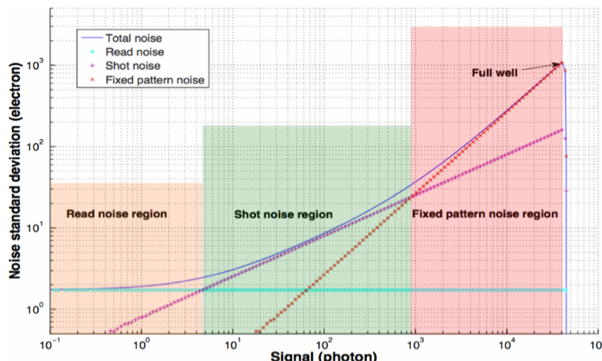
Fig. 1. A simulated PTC. Three noises can be seen as the dominant source at di®erent signal levels: read noise, shot noise, and FPN.